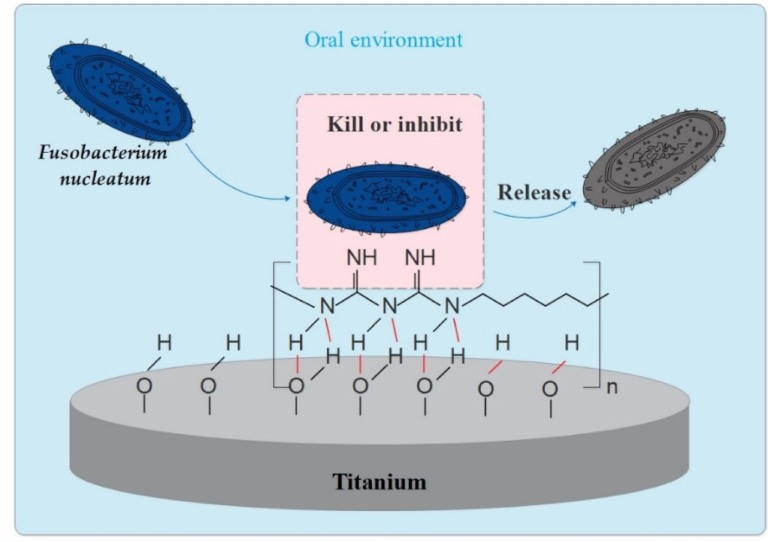
Figure 6. Anti- F. nucleatum action model of PHMB-coated Ti for i) illustration of hydrogen bonding (red lines) or physiochemical adsorption between PHMB and UV-treated Ti; ii) the F. nucleatum was killed or inhibited by the Guanidine group on